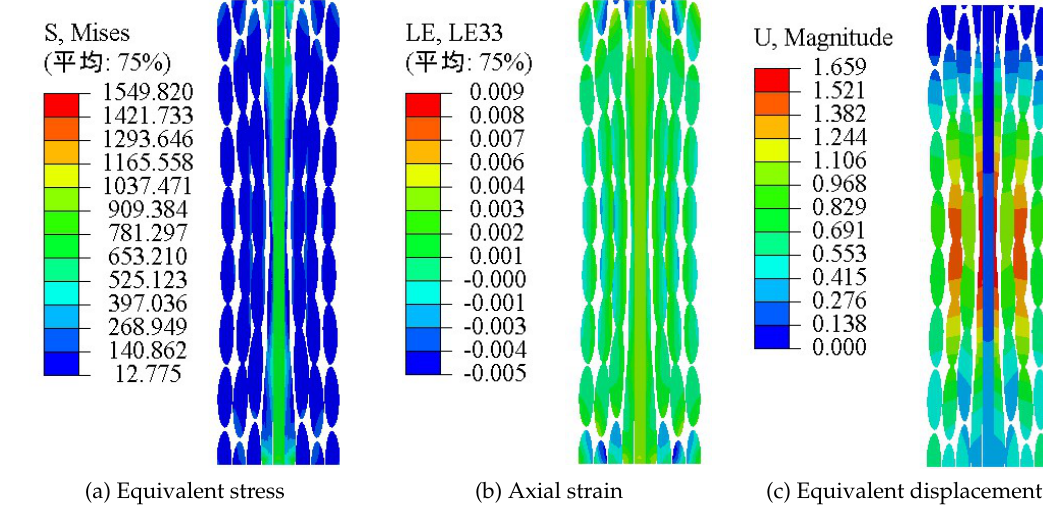
Fig. 8. Overall longitudinal section nephogram of the positive